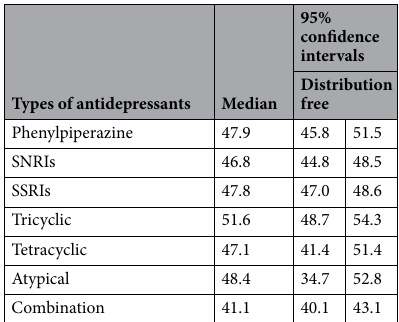
Table 2. Mental health-related quality of life associated with antidepressants***. SSRIs: Selective serotonin reuptake inhibitors; SNRIs: Serotonin and norepinephrine reuptake inhibitors; Combination: Patients using multiple antidepressants. *** p < 0.001.